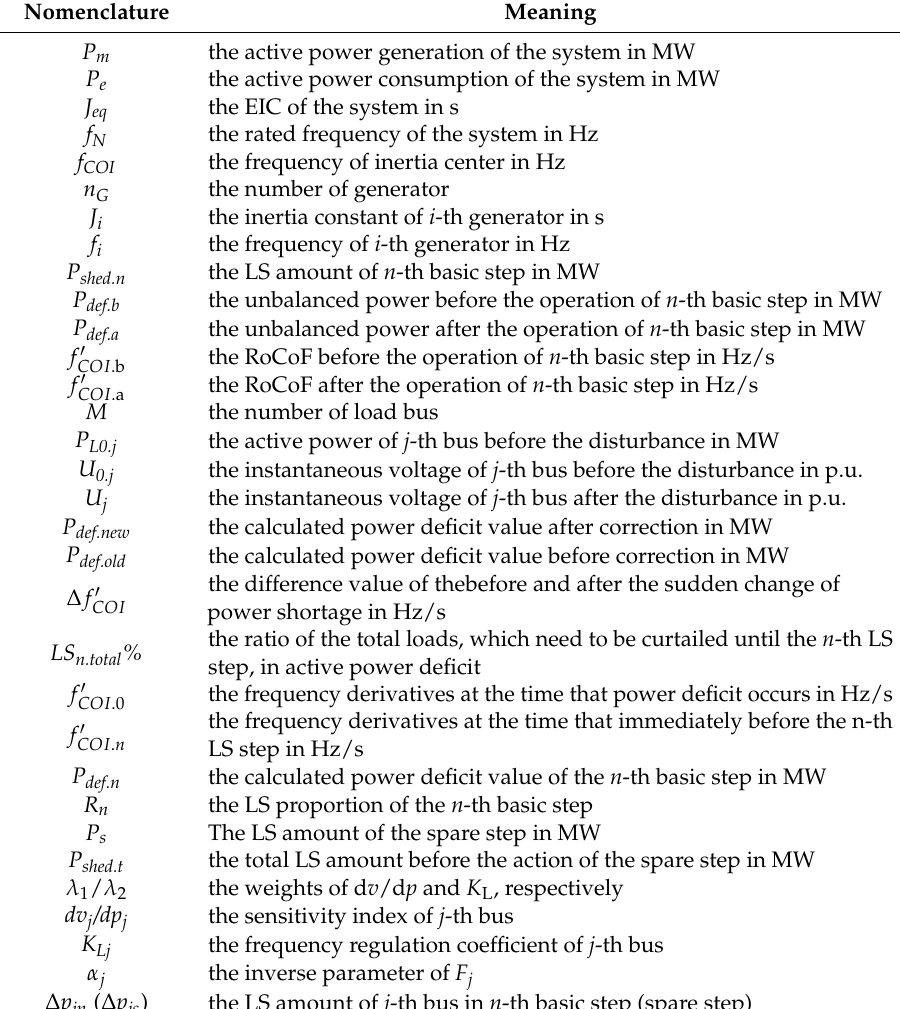
Table A4. The nomenclature and its